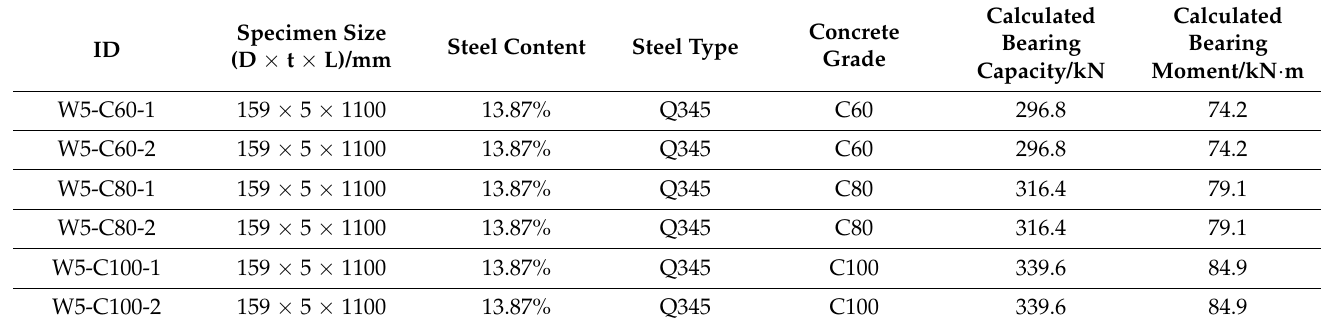
Figure 2. UHSCFST bending specimens (mm). Table 2. List of flexural test components.